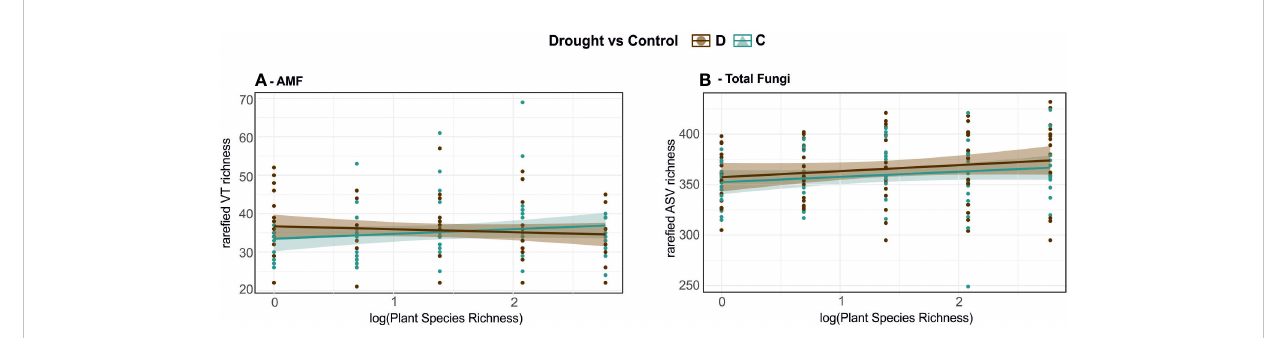
FIGURE 3 Alpha-diversity of AMF and total fungal communities according to plant species levels and treatments. (A) Observed AMF VT richness and (B) total fungal ASV richness after rarefaction versus log-transformed plant species richness (1 to 16). Treatments: brown – drought; teal – control